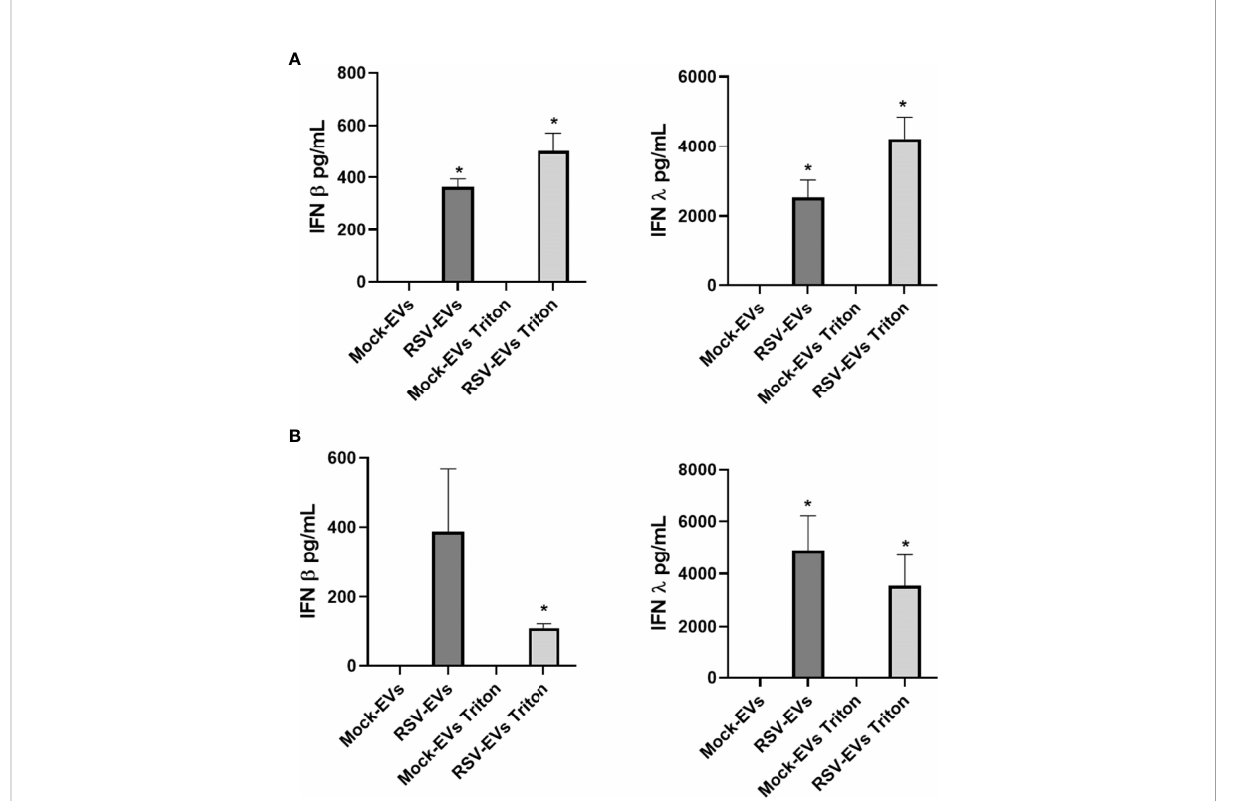
FIGURE 2 IFN- b and IFN- l concentrations associated with EVs released from mock- and RSV-infected A549 (A) and SAE cells (B) . IFN- b and IFN- l were measured by ELISA as intact or Triton lysed EVs. Data are presented as mean ± SEM. * indicates a statistical difference comparing RSV- EVs or RSV-EVs Triton versus Mock-EVs or Mock-EVs Triton, respectively (* p value < 0.05). Data represents the average of three independent